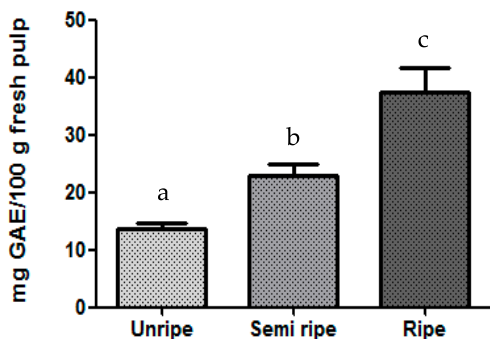
Figure 1. Total phenols content in unripe, semi-ripe and ripe Sicana odorifera fruit pulp. The bars represent the mean ± SD (n = 3). Different letters on the bars indicate significant differences between the means (ANOVA, Tukey’s test a posteriori, p ≤ 0.05).